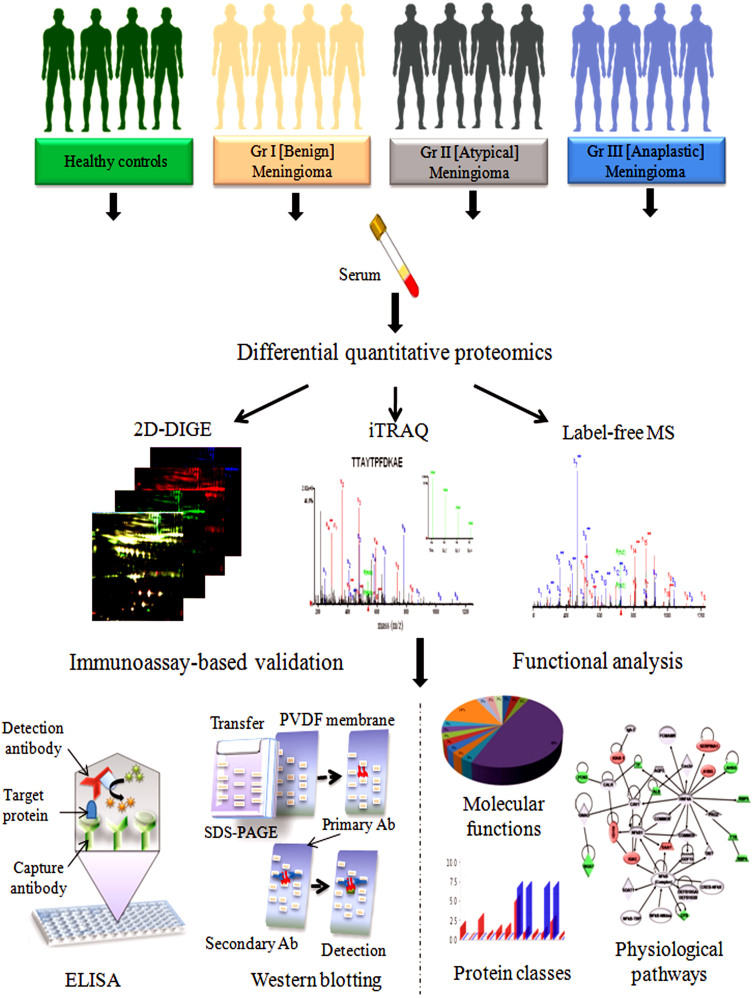
Schematic representation of the experimental strategy for proteomic analysis of alterations in the human serum proteome in different grades of human meningiomas (Drawn by the authors: S.S1 & S.R.).